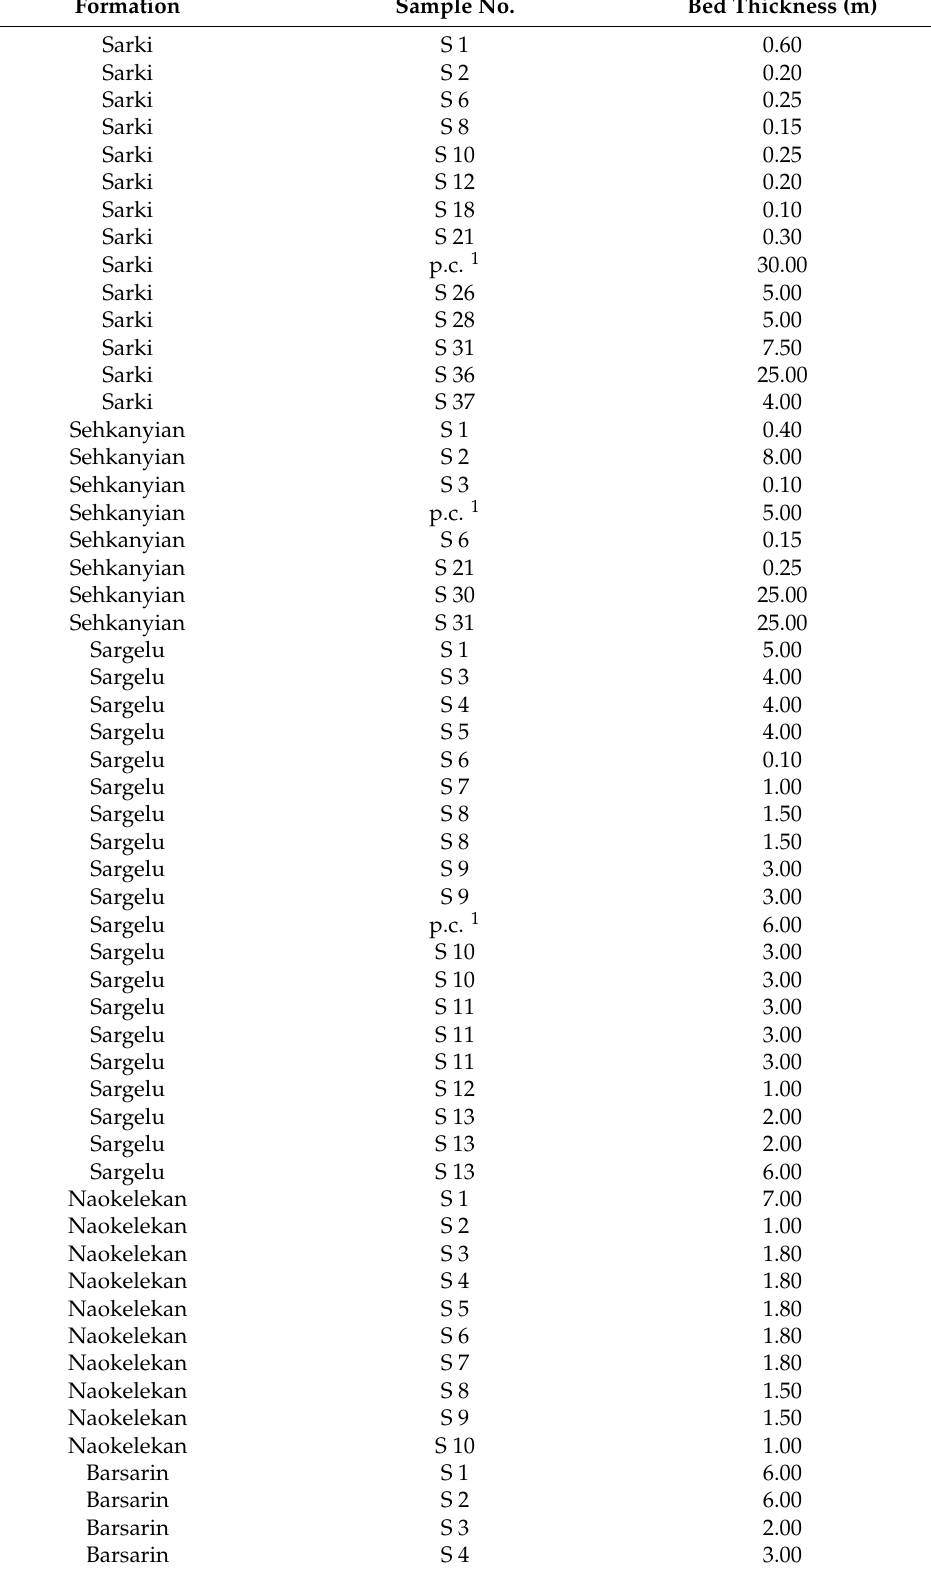
Table 1. Simplified table showing the precise stratigraphic position of the studied samples from the Sarki, Sehkaniyan, Sargelu, Naokelekan, Barsarin and Chia Gara formations. Formation Sample